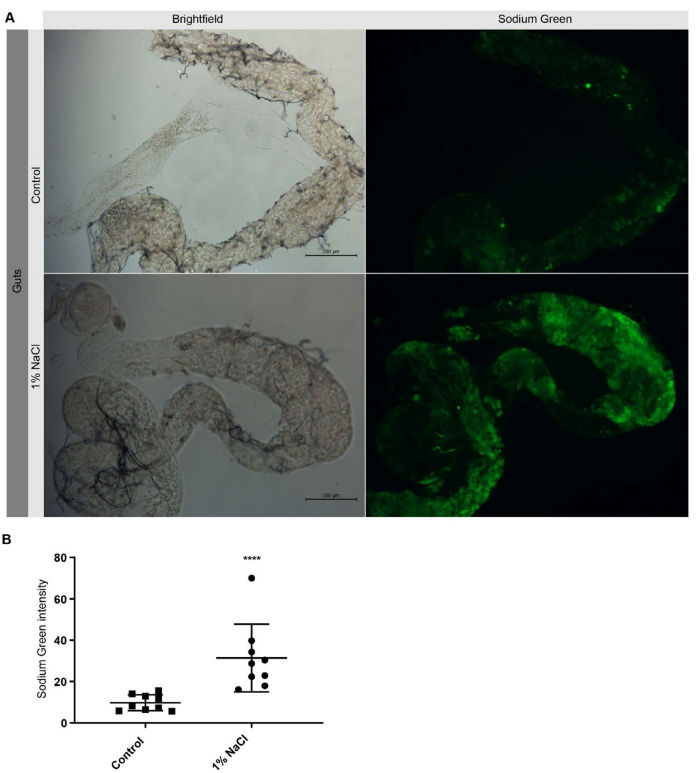
Figure 1. Elevated Na + in the midgut of HSD flies. ( A ) Na + concentration in midgut of control and HSD flies indicated by Sodium Green staining. ( B ) Quantitative measurements of Sodium Green intensity. **** p <